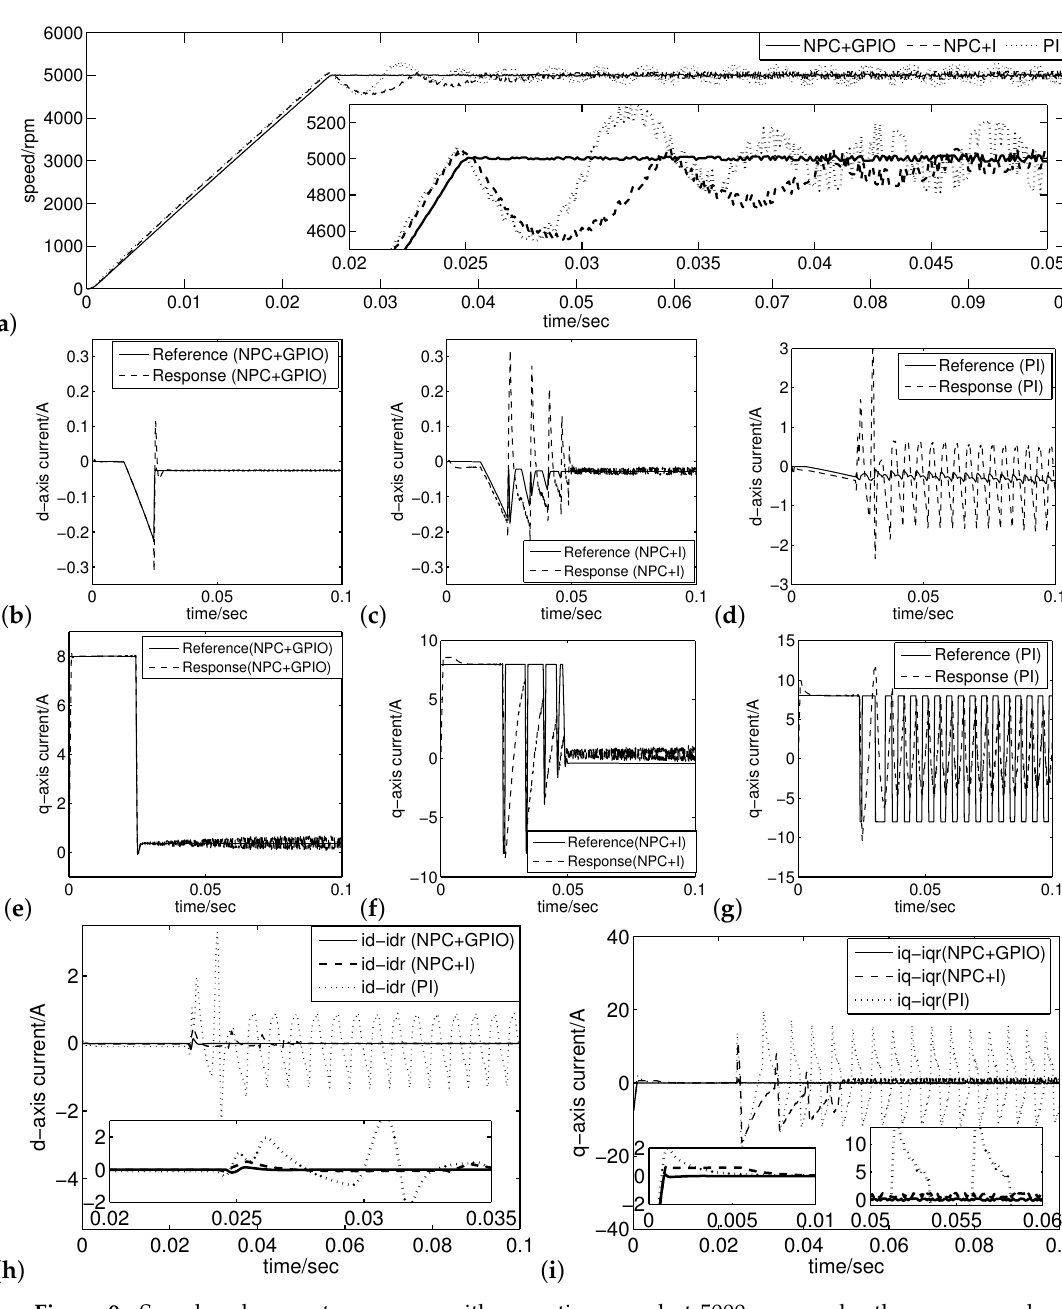
Figure 9. Speed and current responses with operation speed at 5000 rpm under the same speed controller (PI) and the different current controllers (the proposed controller (NPC + GPIO), the integral controller (NPC + I) and the improved PI controller): ( a ) speed responses; ( b ) d-axis current response under the proposed controller; ( c ) d-axis current response under the integral controller; ( d ) d-axis current response under the PI controller; ( e ) q-axis current response under the proposed controller; ( f ) q-axis current response under the integral controller; ( g ) q-axis current response under the PI controller; ( h ) d-axis current-tracking errors under the different current controllers (the d-axis response current (id) minus the d-axis reference current (idr)); ( i ) q-axis current-tracking errors under the different current controllers (the q-axis response current (iq) minus the q-axis reference current